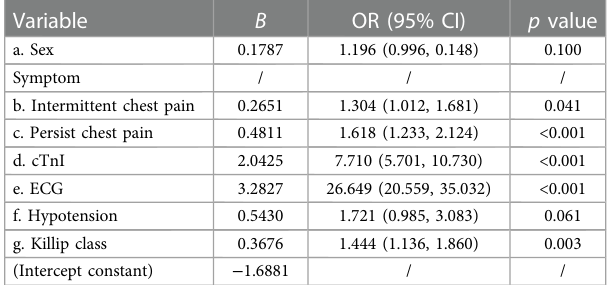
TABLE 3 Multivariate logistic regression model of the training